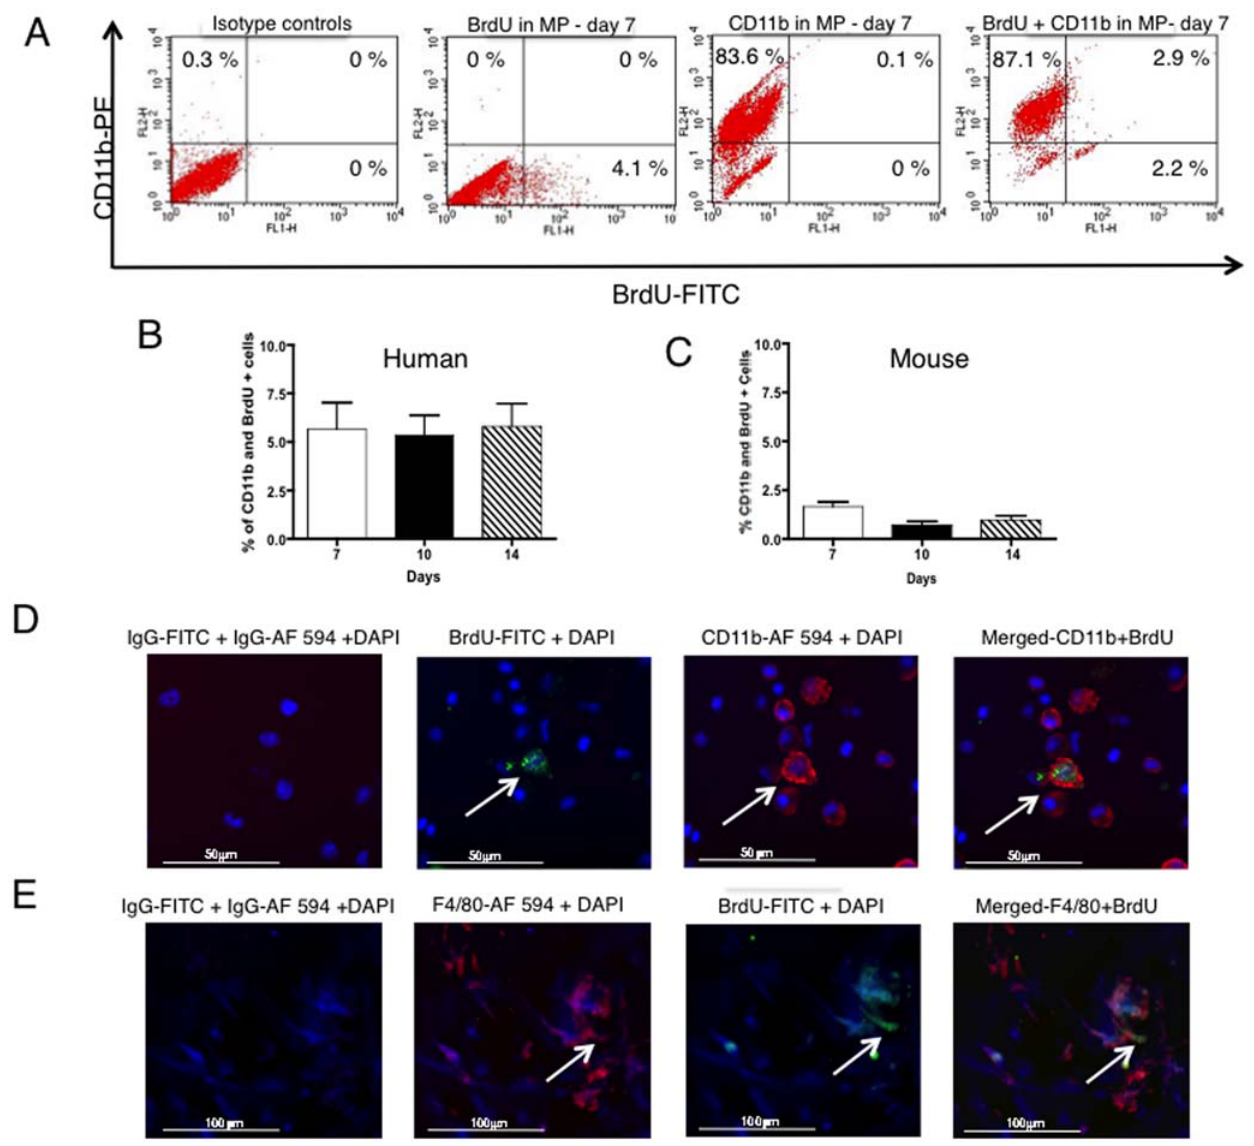
Figure 4. BrdU uptake by local infiltrating Matrigel TM plaque macrophages from BrdU-labeled BMSCs. Representative flow cytometry dot plots showing 2.9% of CD11b-PE and BrdU-FITC positive macrophages in MPs harvested seven days post-implantation (A), Bar graph showing the mean percentage of BrdU + CD11b + cells in all MPs collected 7, 10 and 14 days after implantation of MPs containing 2 6 10 6 xenogenic hBMSCs (B) and 2 6 10 6 syngeneic mouse BMSCs (C). Note the uptake of BrdU by tissue macrophages was lower from syngeneic BrdU – labeled mouse BMSCs when compared to xenogenic BrdU-labeled hBMSCs. Immunofluorescent detection of BrdU with anti-BrdU-FITC, CD11b with anti-mouse CD11b-Alexa Fluor 594 on cytospins of cells recovered from MPs seven days post-implantation (magnification 40X), (D). On the merged image, note cells only positive for CD11b-Alexa Fluor 594 and macrophages positive for BrdU-FITC and CD11b-Alexa Fluor 594. Those cells are local macrophages that took up BrdU from BrdU labeled hBMSCs. Immunofluorescent detection of BrdU with anti-BrdU-FITC, F4/80 with anti-mouse F4/80-Alexa Fluor 594 on frozen sections of MPs seven days post-implantation (magnification 40X), (D). Cells positive for macrophage marker, F4/80, as well as BrdU are indicated by arrows. Data are presented as a mean 6 1 SD from 12